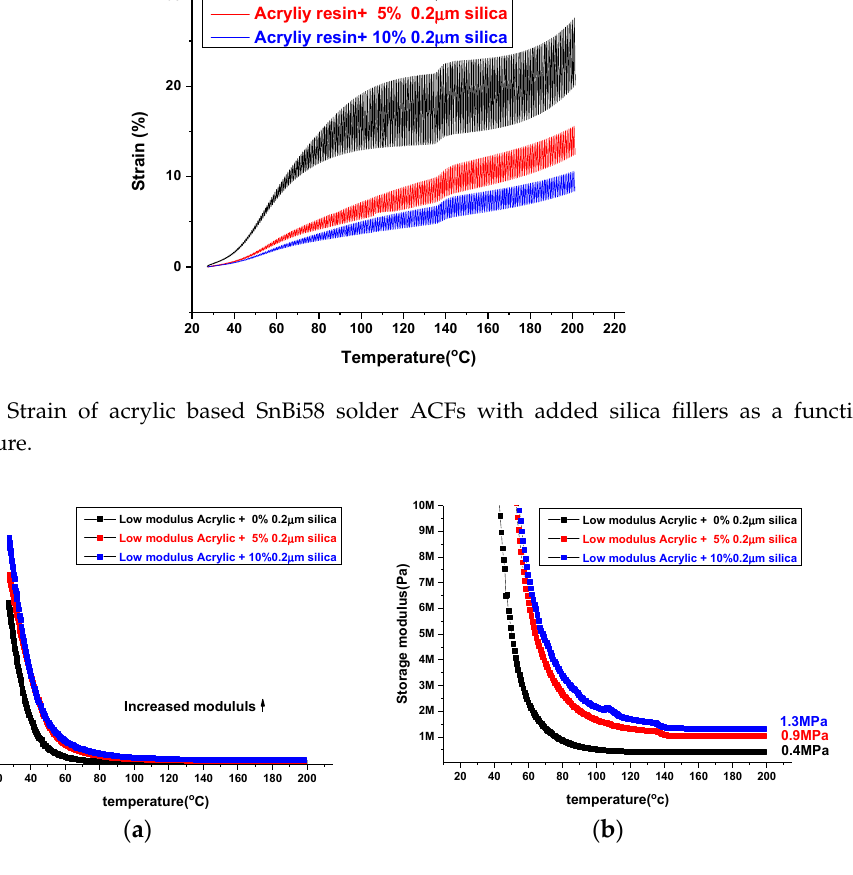
Figure 24. Elastic modulus of acrylic based SnBi58 solder ACFs by adding 0, 5, and 10 wt % 0.2 μ m silica fillers at ( a ) 0–80 MPa and ( b ) 0–10 MPa ranges.